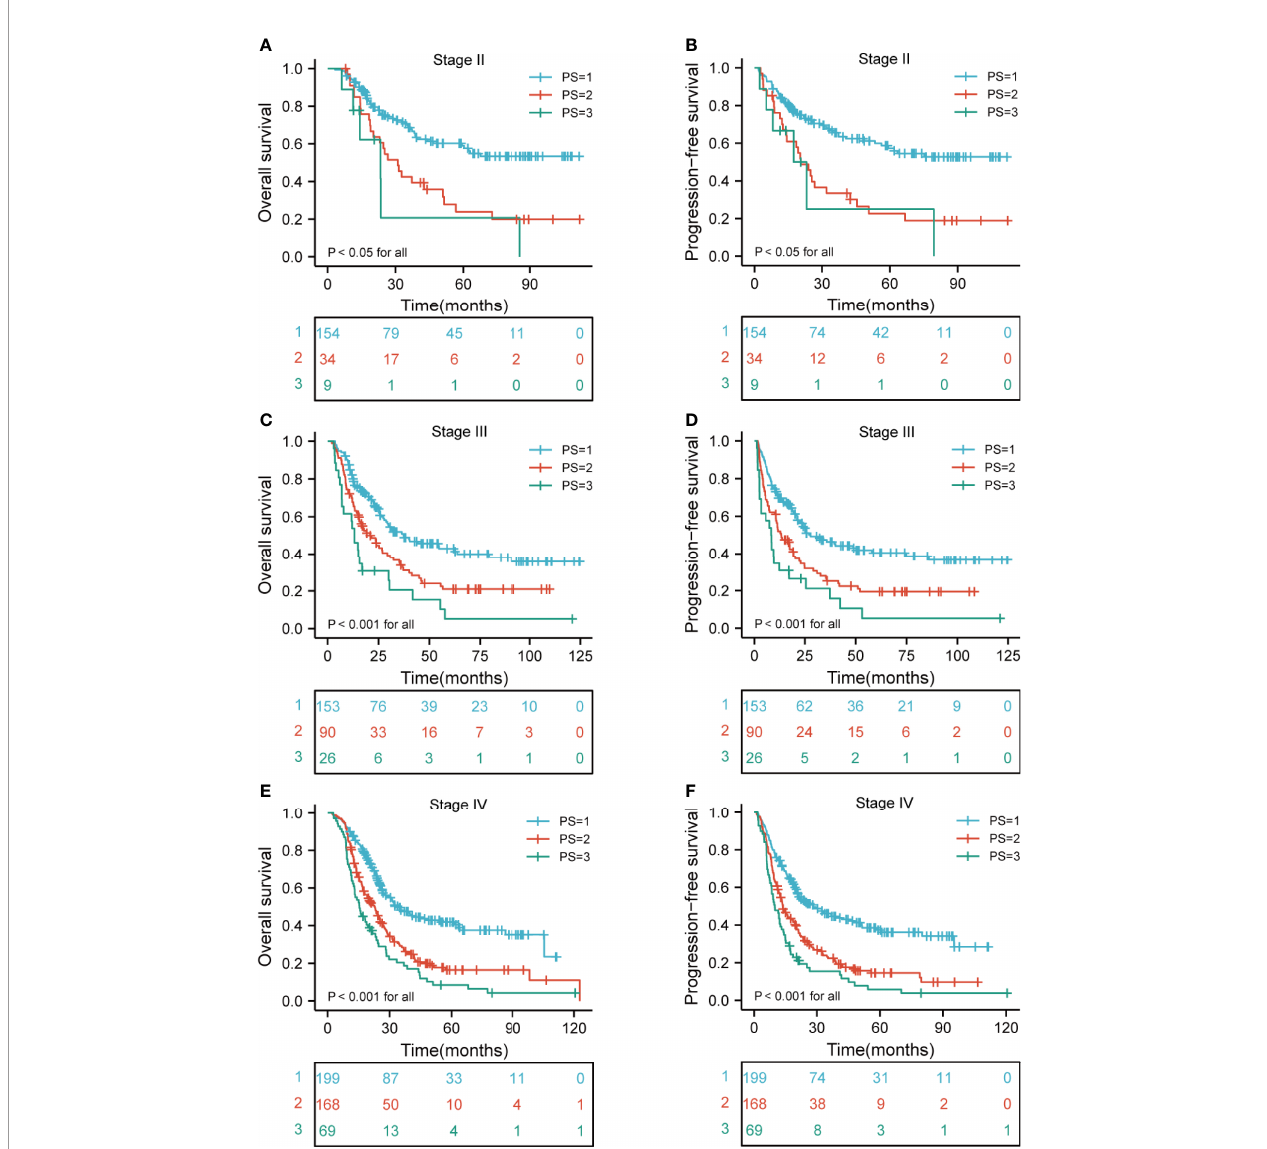
FIGURE 5 | Kaplan-Meier curves according to TNM stage categories for the whole study population according to risk groups showing (A – F) OS and PFS (p < 0.05 for all) of patients with stage II-IVA. TNM, tumor-node-metastasis; OS, overall survival; PFS, progression-free